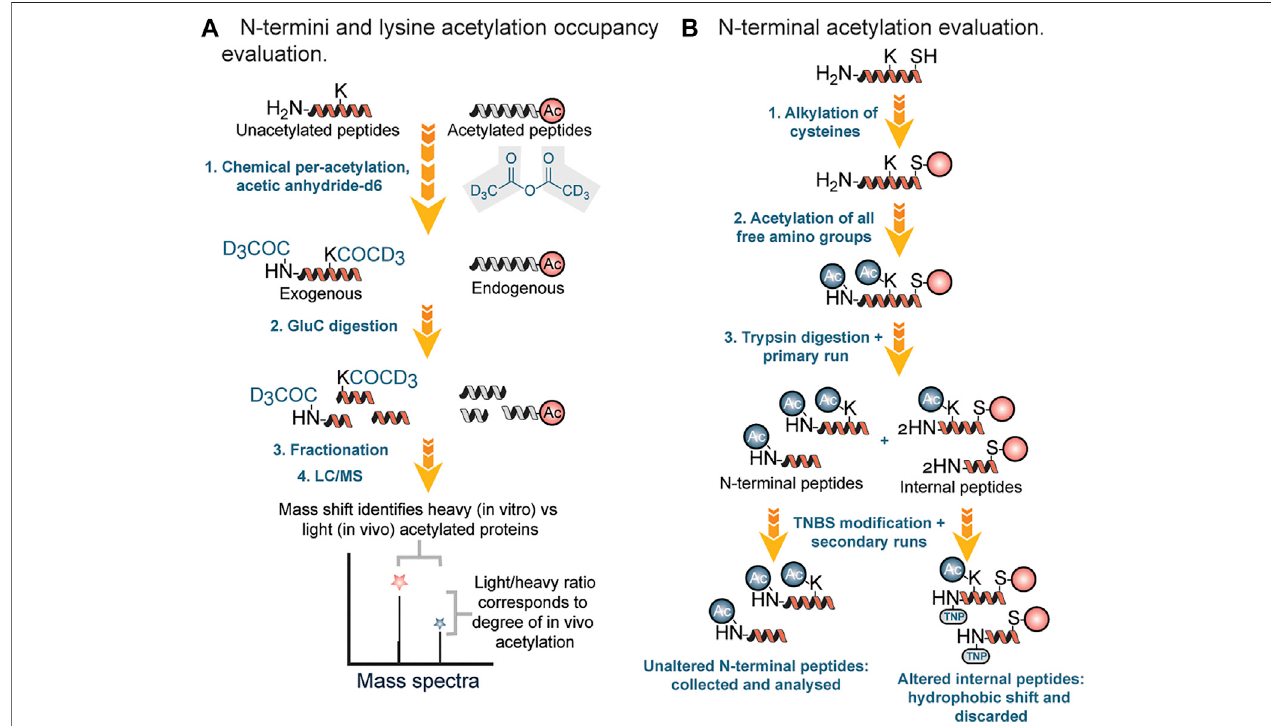
FIGURE 4 | (A) Stoichiometry work fl ow for evaluation of N-terminal and lysine acetylation based on occupancy ratio. (B) Chemical and chromatographic steps for identi fi cation of N-terminal acetyl modi fi ed